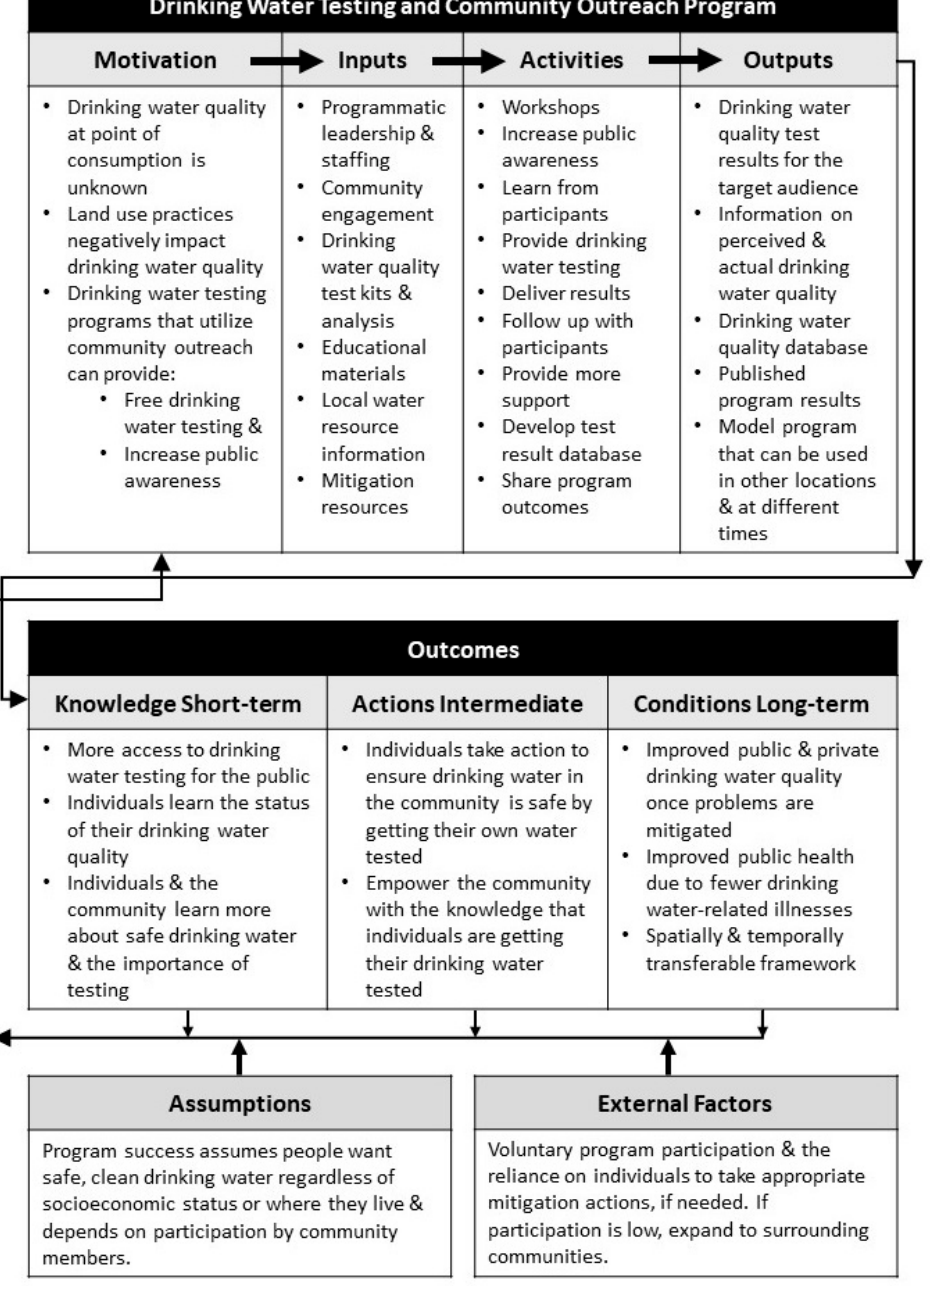
Figure 1. Many of the fundamental components of a drinking water testing and outreach program including the motivation, inputs, activities, outputs, outcomes, assumptions and external